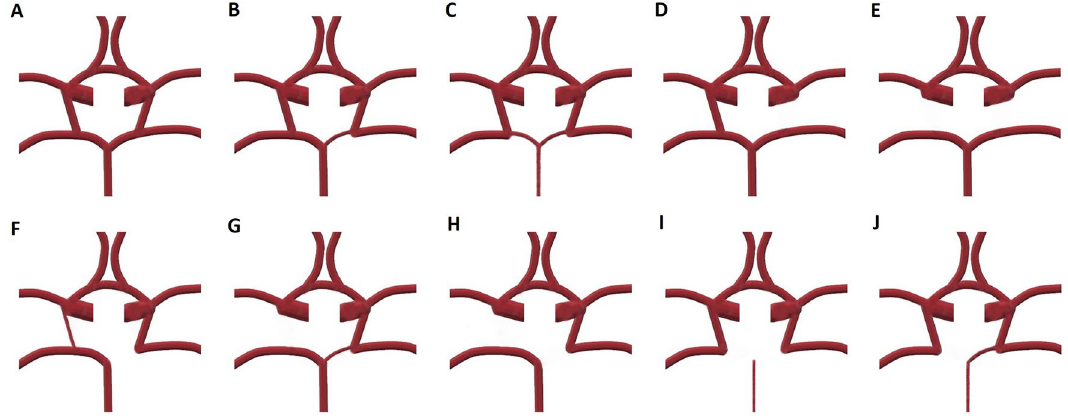
Figure 4. Schematic diagrams showing the anatomical variations in the posterior part of the circle of Willis (COW). Type A: normal anatomical morphology with all of the components of the COW. Type B: the posterior cerebral artery originates predominantly from the ICA. This variation has been described as unilateral fetal type PCA (where PCom has a larger diameter than P1). Type C: bilateral fetal type PCA (usually basilary artery hypoplasia accompanies this variation). Type D: absence of unilateral PCom. Type E: absence of both PComs and isolation of the posterior circulation. Type F: unilateral fetal type PCA and hypoplasia of the PCom on the contralateral side. Type G: unilateral fetal type PCA and contralateral PCom aplasia or hypoplasia. Type H: unilateral fetal type PCA and aplasia or hypoplasia of the P1 segment and PCom. Type I: bilateral fetal type PCAs with absence or hypoplasia of both P1 segments. Type J: bilateral fetal type PCAs with absence or hypoplasia of the P1 segment of either posterior cerebral artery ( PCom posterior communicating artery, PCA posterior cerebral artery, ICA internal carotid artery).